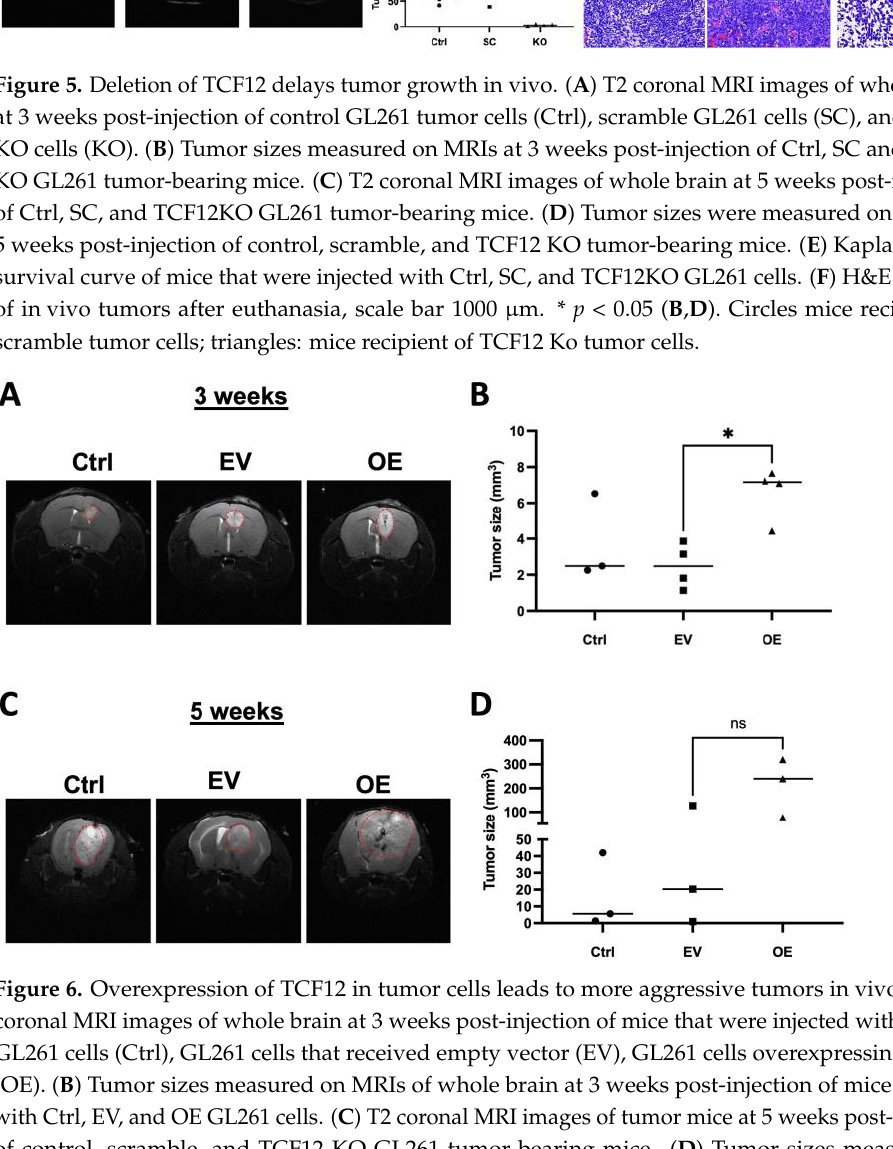
Figure 5. Deletion of TCF12 delays tumor growth in vivo. ( A ) T2 coronal MRI images of whole brain at 3 weeks post-injection of control GL261 tumor cells (Ctrl), scramble GL261 cells (SC), and TCF12 KO cells (KO). ( B ) Tumor sizes measured on MRIs at 3 weeks post-injection of Ctrl, SC and TCF12 KO GL261 tumor-bearing mice. ( C ) T2 coronal MRI images of whole brain at 5 weeks post-injection of Ctrl, SC, and TCF12KO GL261 tumor-bearing mice. ( D ) Tumor sizes were measured on MRIs at 5 weeks post-injection of control, scramble, and TCF12 KO tumor-bearing mice. ( E ) Kaplan–Meier survival curve of mice that were injected with Ctrl, SC, and TCF12KO GL261 cells. ( F ) H&E staining of in vivo tumors after euthanasia, scale bar 1000  m. * p < 0.05 ( B , D ). Circles mice recipient of